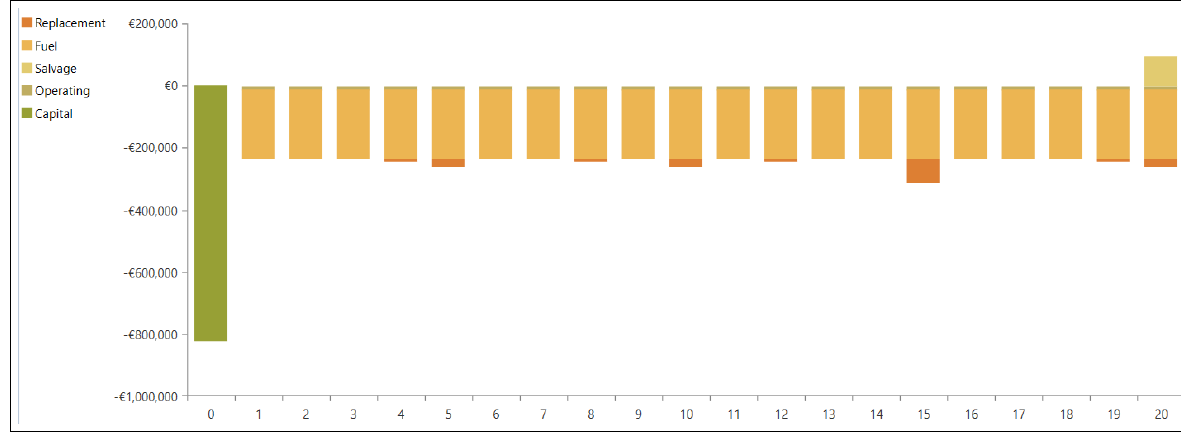
Figure 16. Cash flow by Cost Type Scenario 2. Table 21. Analytical costs of each component Scenario